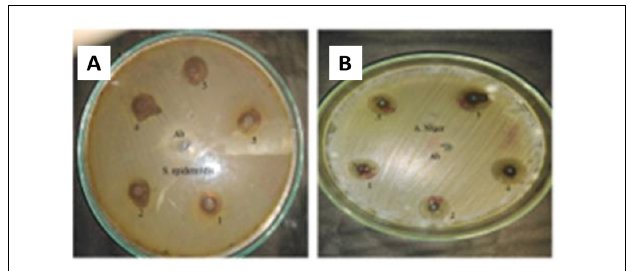
FIGURE 6 | (A) Example of ZnO-NP antibacterial activity against S. epidermidis . (B) Example of ZnO-NP antifungal activity against A. niger .